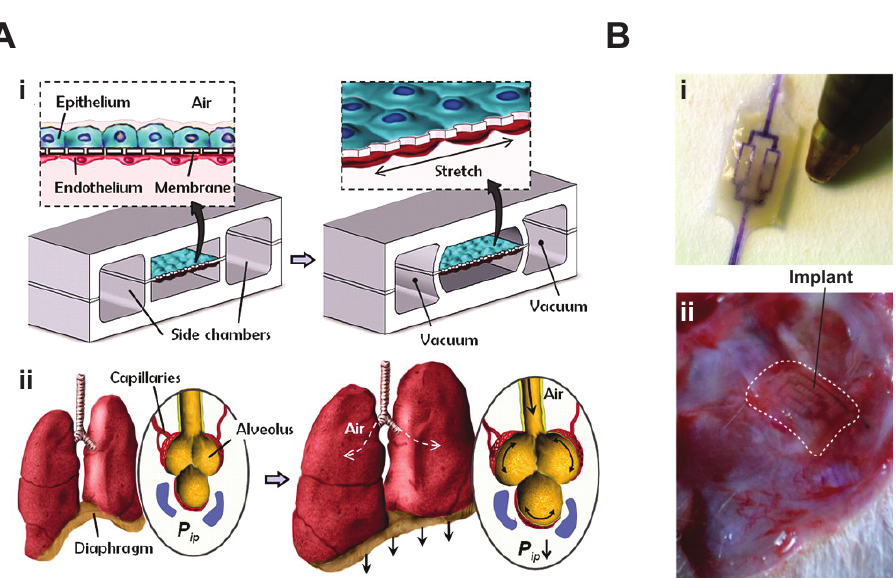
Figure 2. Organ-on-a-chip technologies as engineered biohybrid machines. ( A ) A lung-on-a-chip system was constructed based on ( i ) integrated epithelium and endothelium and integrated respiratory mechanics to mimic ( ii ) the alveolar–capillary interface [24]. ( B ) The ( i ) AngioChip is a porous, biodegradable sca ff old based on a branched, fluid channel that mimics vascularized cardiac and hepatic tissue. This biohybrid system mechanically supported perfusion and promoted angiogenesis (i.e., new vessel growth). It also performed in vivo after ( ii ) surgical implantation with rat femoral vessels [25]. Images reproduced with permission from Huh et al. Science , 2010 and Zhang et al. Nature Materials ,